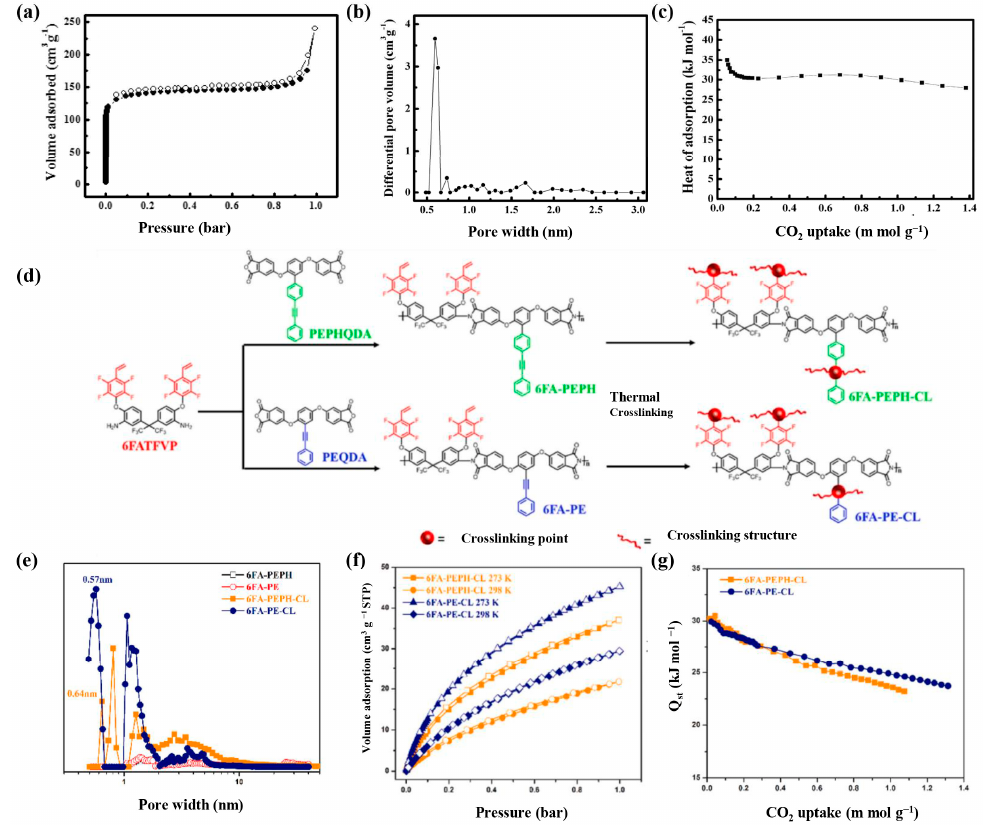
Figure 1. ( a ) N 2 − sorption isotherms at 77 K. ( b ) Pore size distribution. ( c ) Isosteric-heat values of the